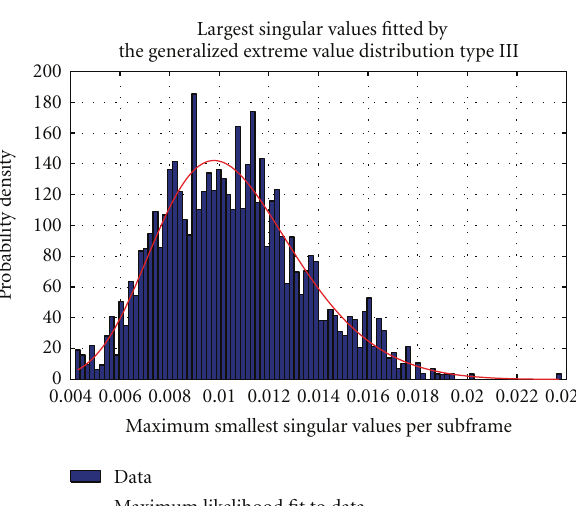
Figure 2: Fitted PDF of the largest singular values on a per subframe